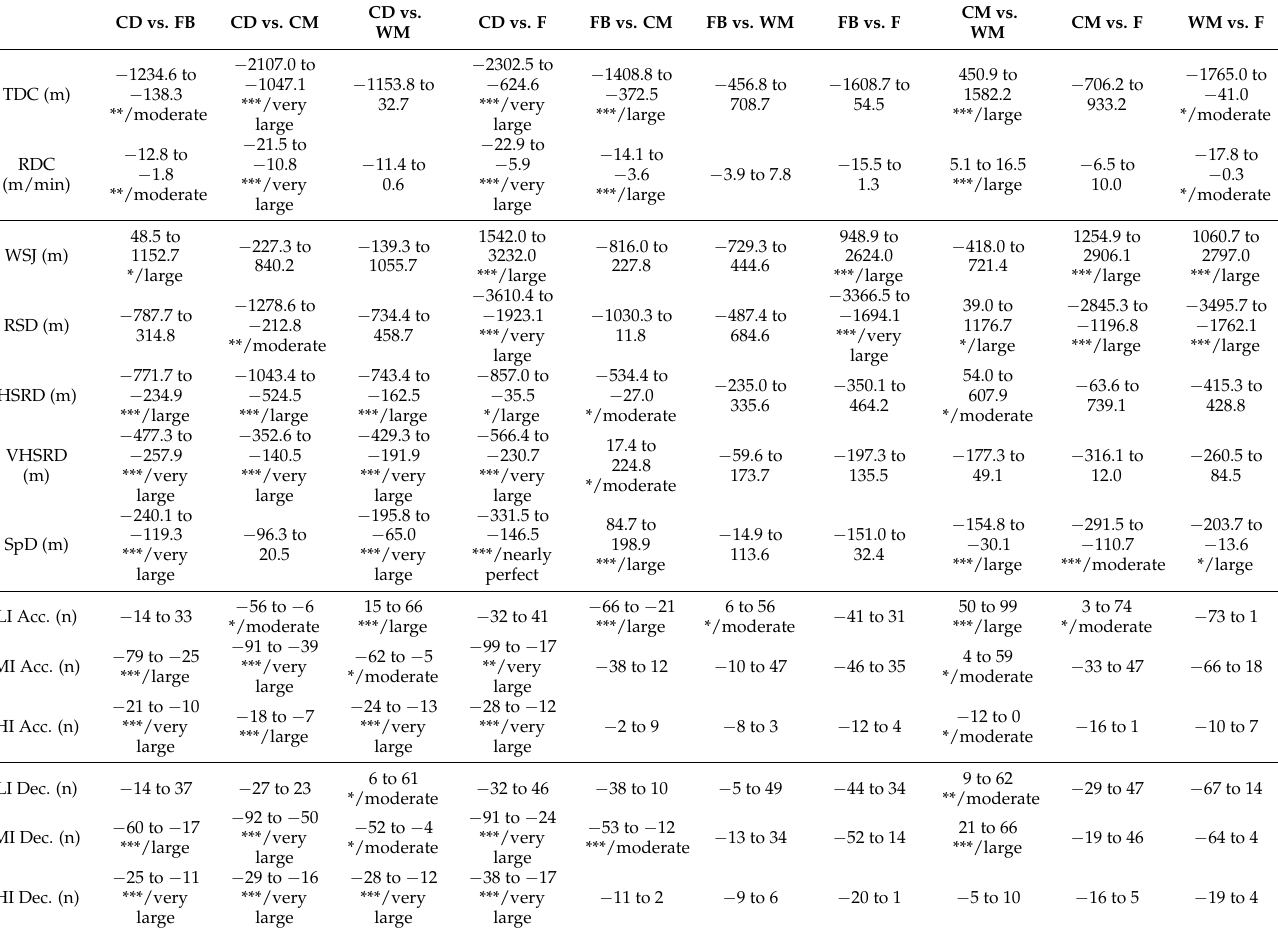
Table 2. External match load—comparison between playing positions, CI 95%, and